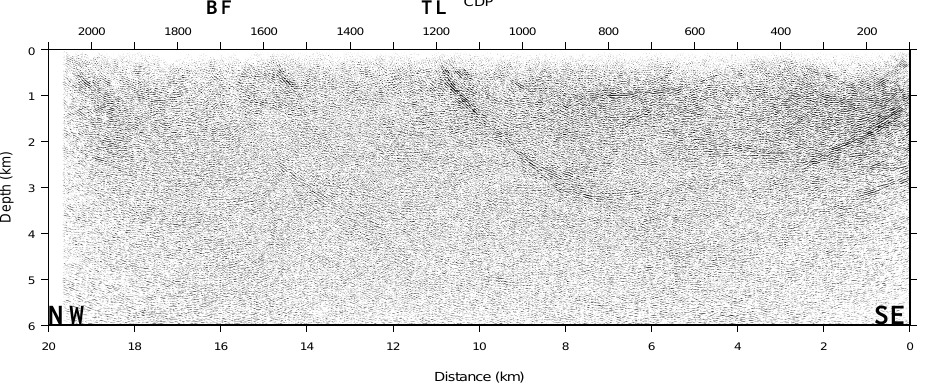
Fig. 5. Depth converted migrated section along the Butr¨ask profile. Surface location of where the profile crosses the Burtr¨ask fault (BF) and a topographic low (TL) are